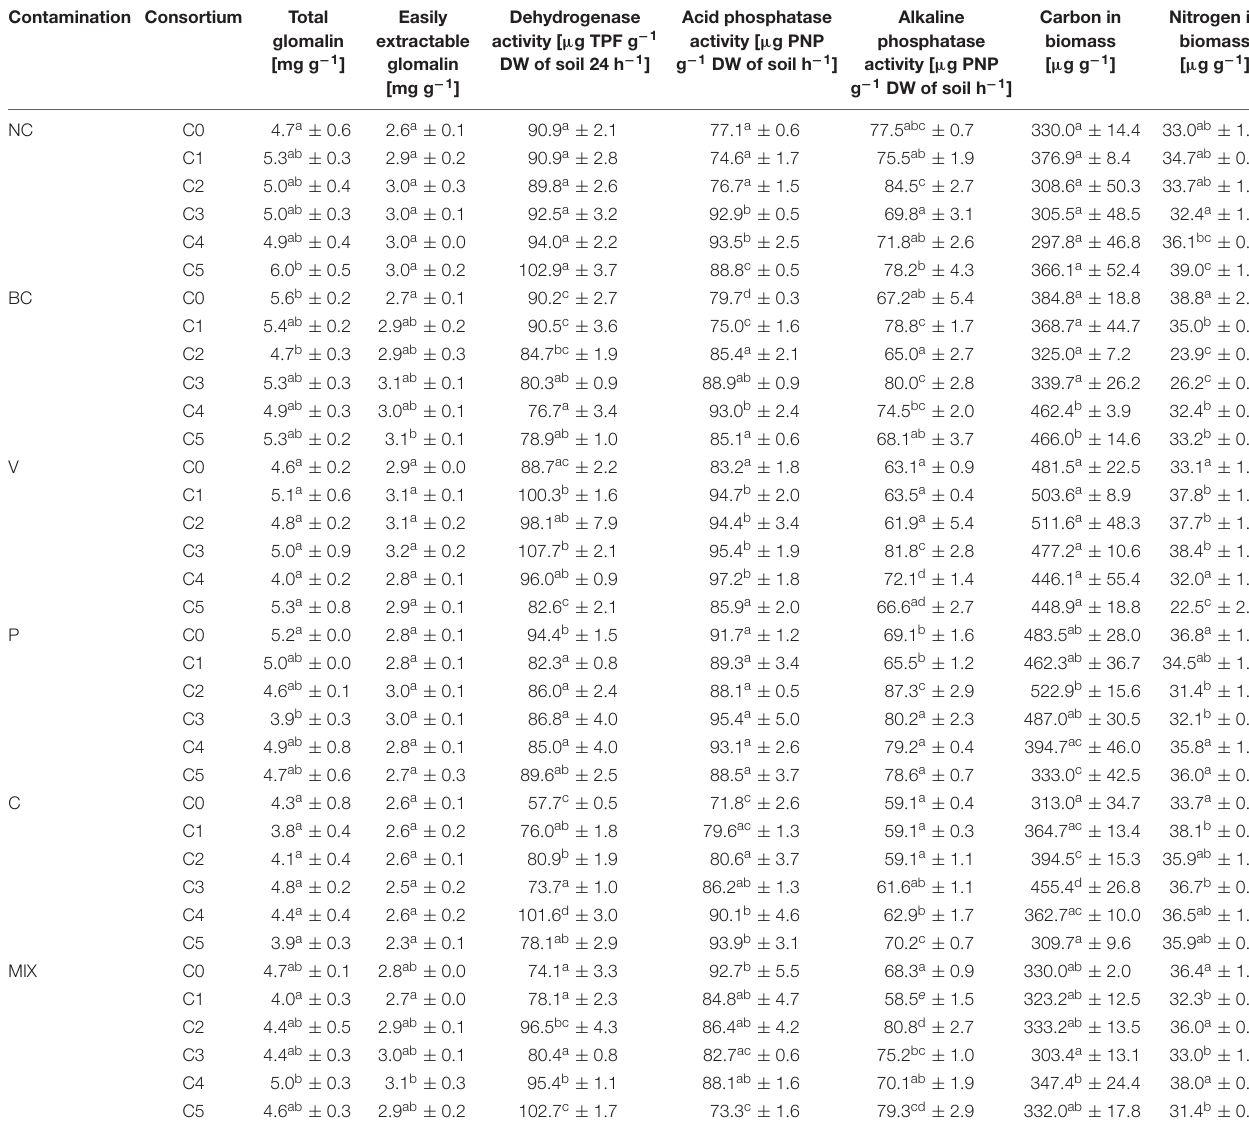
TABLE 3 | Parameters of the quality of soil from strawberry cultivation. Contamination